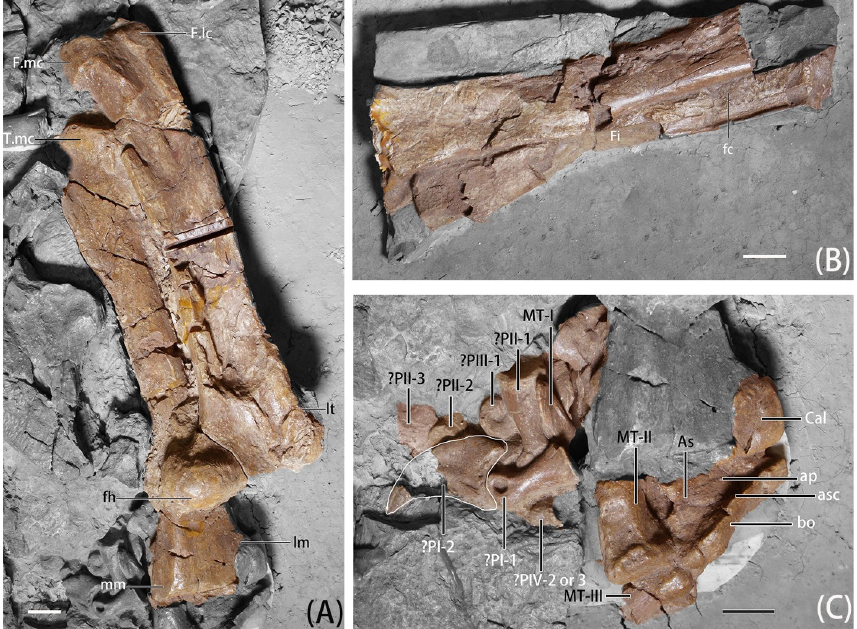
Fig 9. Photographs of hindlimb elements of B . inexpectus (IVPP V 11559) A. right femur in anterior view and tibia in posterior view; B. left tibia and fibula; C. right tarsus and pedal elements. Abbreviations: ap, ascending process; As , astragalus; asc , astragalus condyle; bo , body; Cal , calcaneum; Dt , distal tarsal; F. lc , lateral condyle of femur; F. mc , medial condyle of femur; fc , fibular crest; fh , femoral head; Fi , fibula; lm , lateral malleolus; lt , lesser trochanter; mct , medial crest; mm , medial malleolus; MT I-III , metatarsus I-III; ?PI-1 to ?PIV-3 , ?phanlanges I-1 to IV-3; T.mc , medial condyle of tibia. Scale bars equal 2 cm.